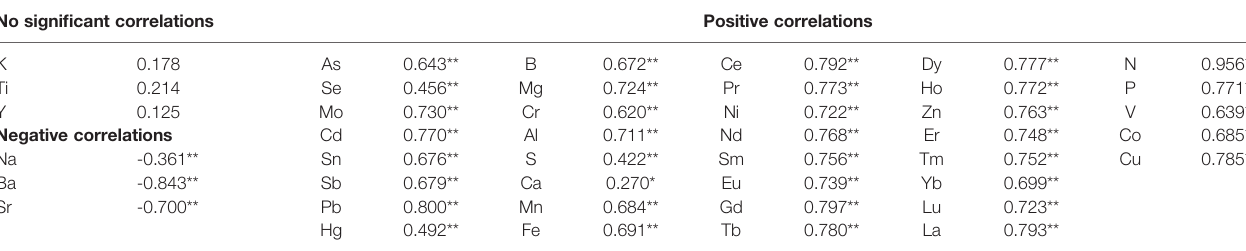
TABLE 3 | Spearman correlation coef fi cients between organic matter content and element concentrations in all sites. No signi fi cant correlations Positive